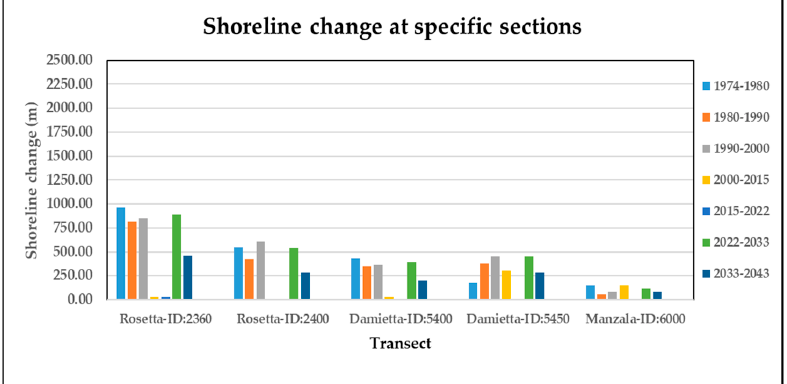
Figure 11. Comparison between shoreline changes at critical sections in the period 1974–2043.